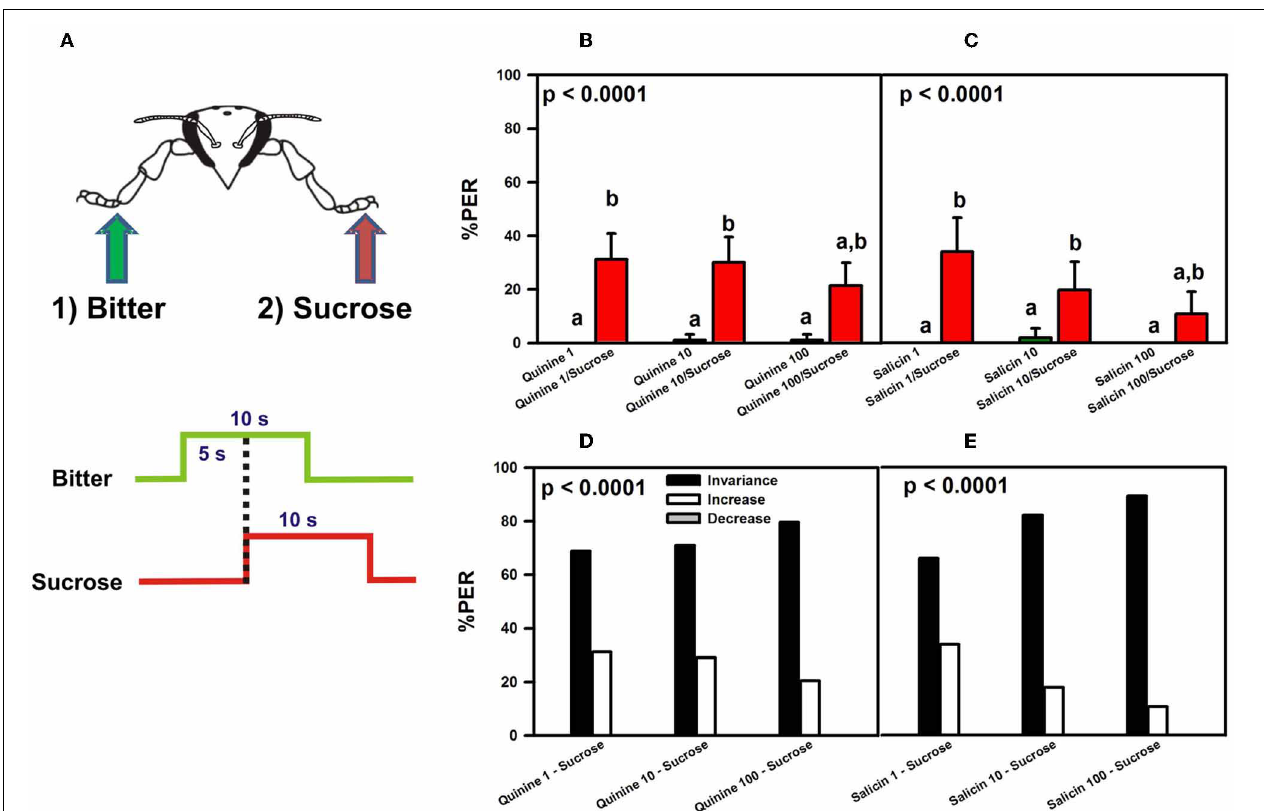
FIGURE 4 | Experiment 2. (A) Bees with intact antennae were stimulated along three trials with quinine or salicin (“bitter,” green arrow, green trace) of different concentrations on one fore-tarsus, and with sucrose solution 1M (red arrow; red trace) on the contralateral fore-tarsus to determine whether sucrose overcomes the potential inhibitory effect of the bitter substance and elicits PER. (B) % PER upon stimulation with quinine (1, 10, and 100mM; green bars) and sucrose 1M (red bars). (C) % PER upon stimulation with